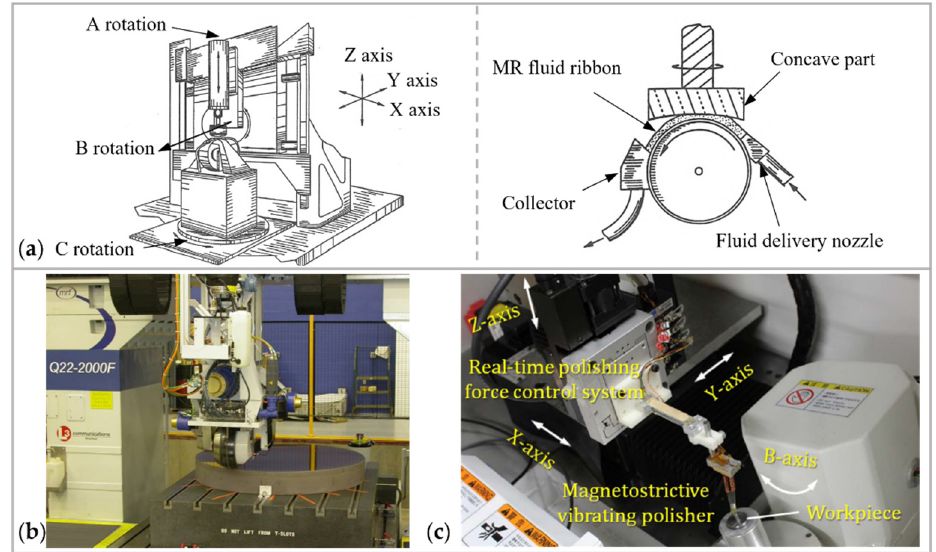
Figure 30. The equipment development of MRF: ( a ) The machine with a vertical wheel-type polishing head [214]; ( b ) Q22-2000F machine [215]; ( c ) The vibration-assisted system [212].